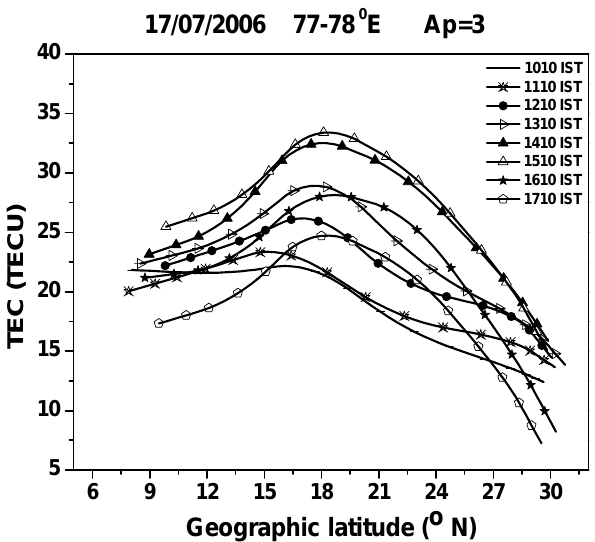
Fig. 1. The evolution of EIA at every 1h interval for a typical quiet day obtained from six GPS stations along 77–78 ◦ E